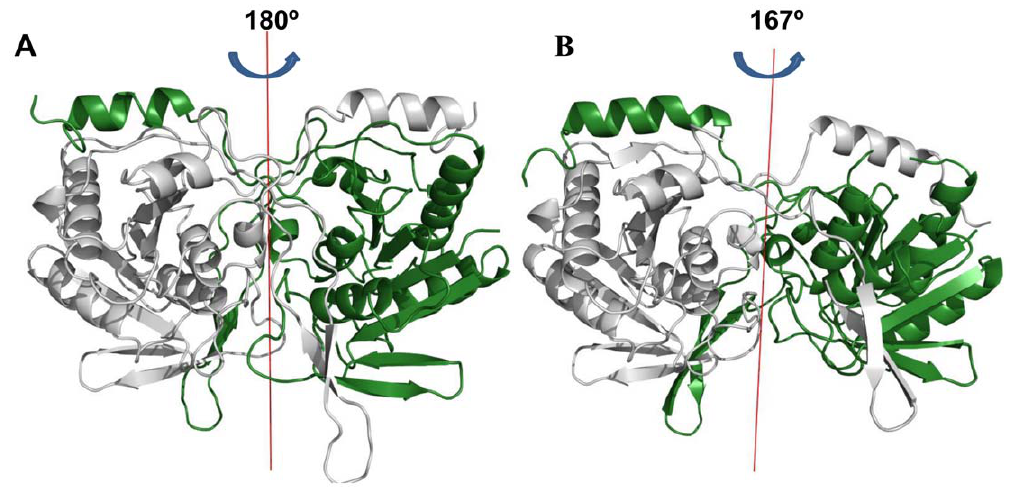
Figure 6. Dimeric structures of wild type and H234A mutant. A) St SurE. B) H234A mutant. The displacement of the rotation axis relating the two subunits in the mutant may be observed.